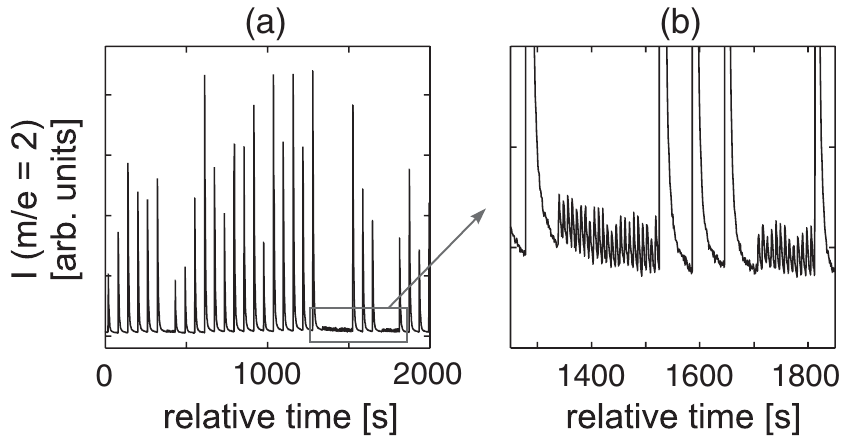
FIG. 12. H 2 outgassing measured with a RGA (current for m=e ¼ 2 ) in a breakdown rate experiment with Cu electrodes, at 5 kV ( BDR ¼ 0 : 1 ). A detailed view of the outgassing during two quiet periods is given in (b). After each attempt, there is a pause of 60 seconds if a breakdown occurred, and 8 seconds otherwise, to allow the pressure to recover to its nominal value.